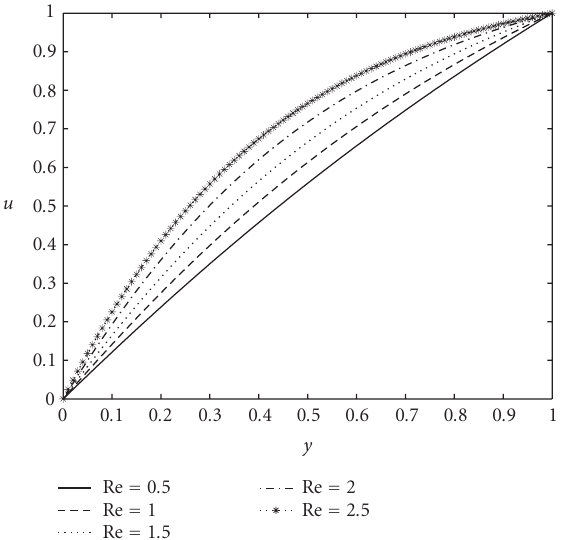
Figure 4.1. Main velocity u for ω = 6 . 0, S = 1 . 0, t = 0 . 2, z = 0 . 0, (cid:3) = 0 . 2.